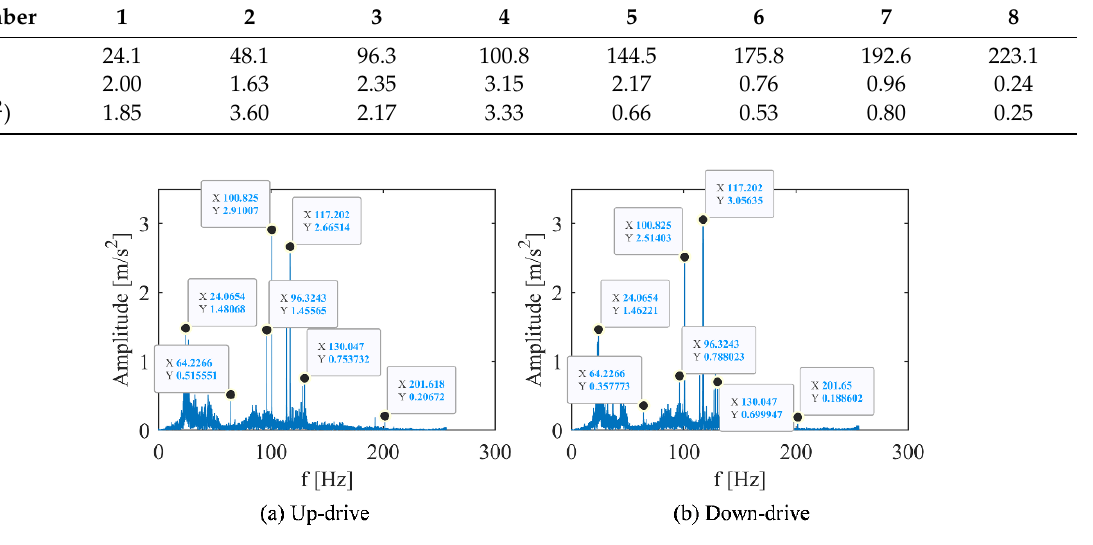
Figure 2. Vibration spectrum diagram of main engine at elevator running speed of 1 m/s. ( a ) Motor with up-drive condition. ( b ) Motor with down-drive condition. Table 3. Frequency domain peak value of vibration response at running speed of 1m/s.